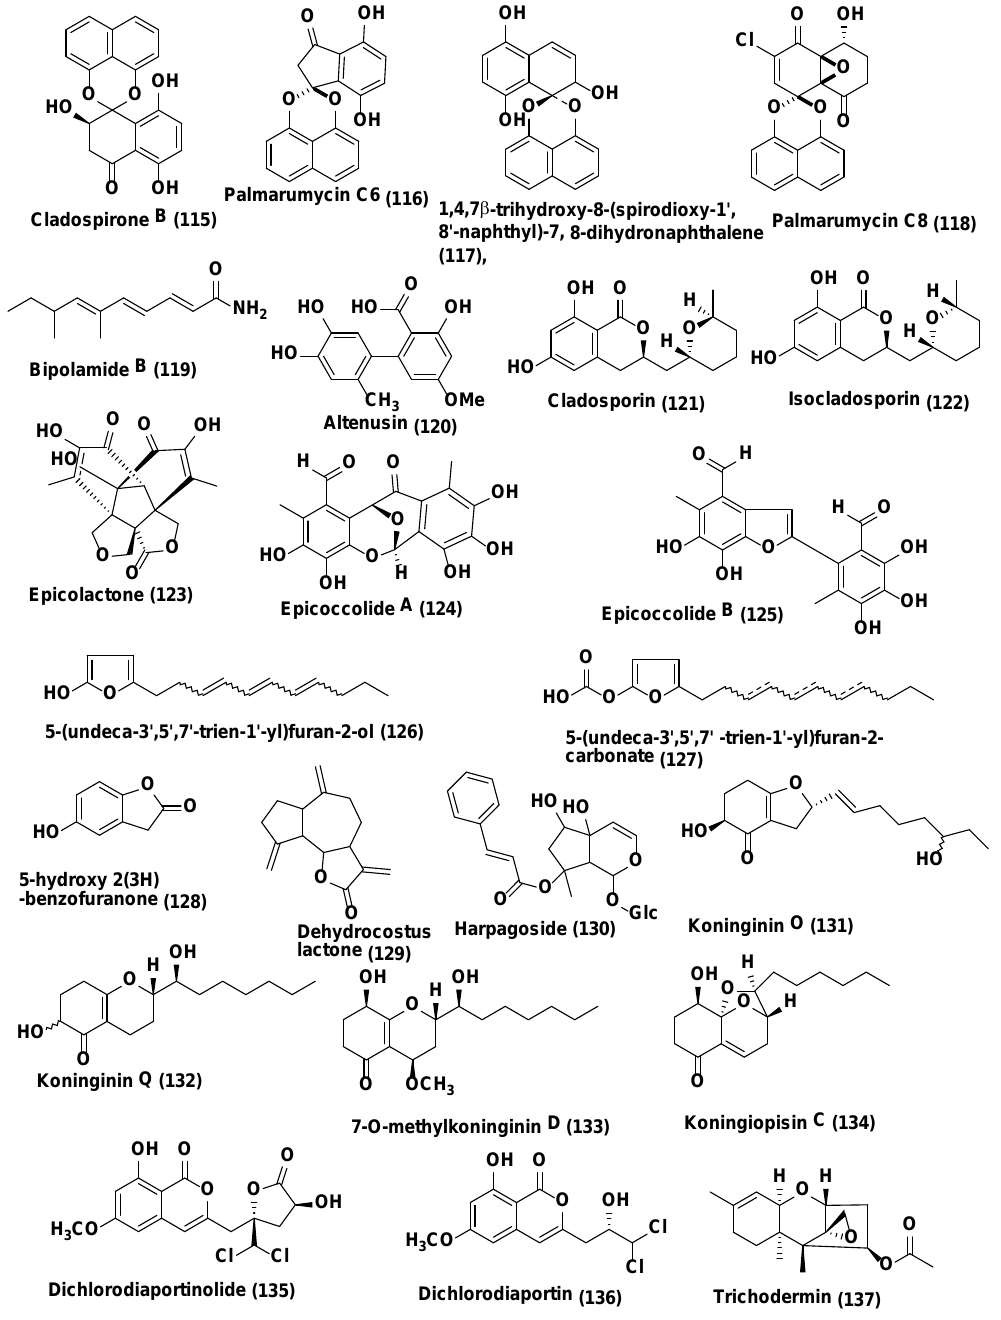
Figure 6. Structures of metabolites isolated from Ascomycetes ( 115 – 127 ) and Hyphomycetes ( 128 – 137 ).